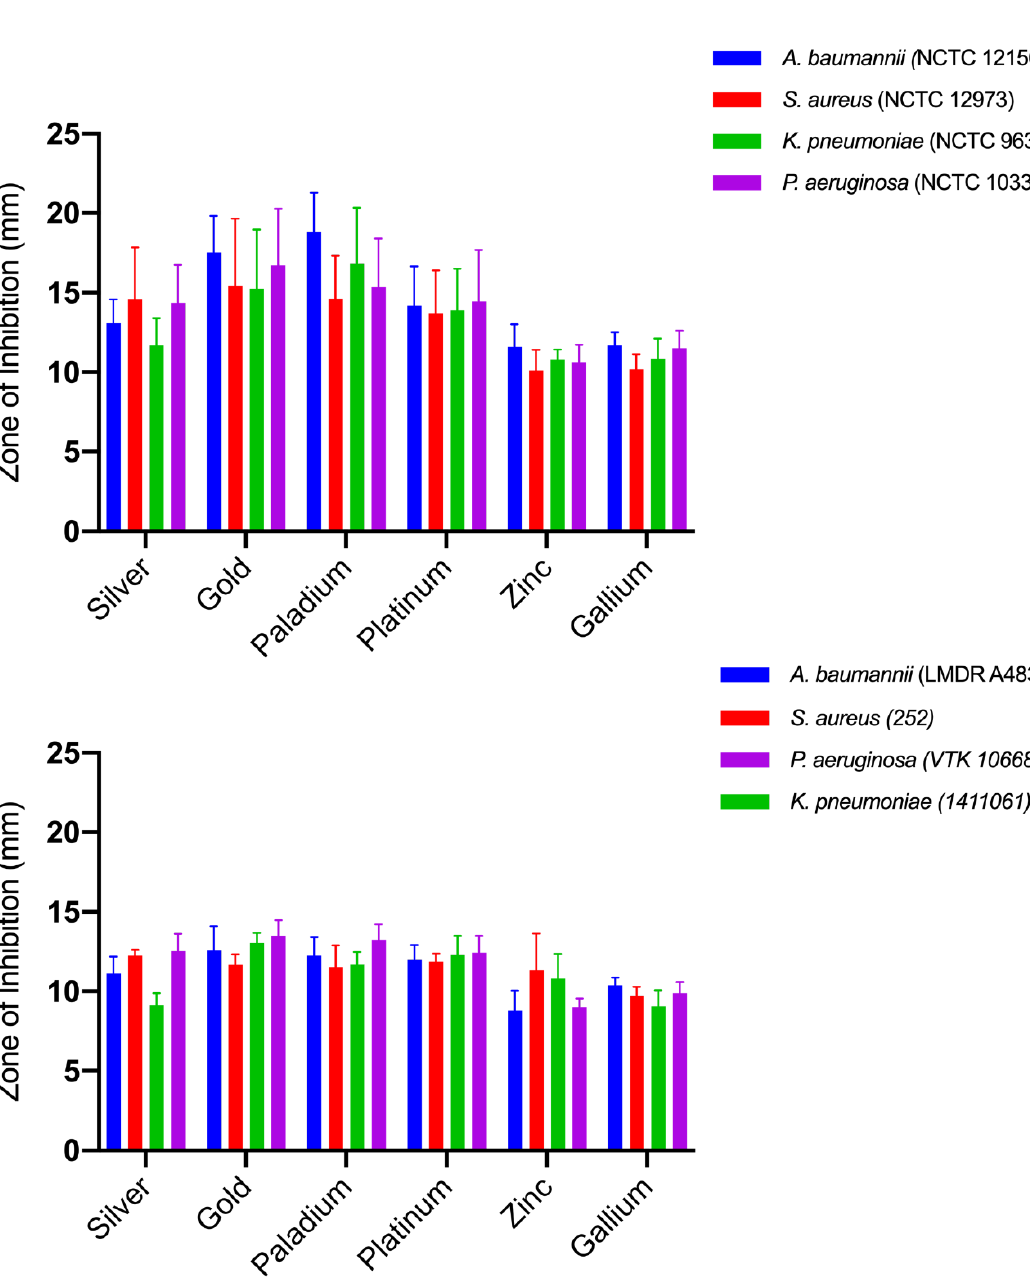
Figure 4. Zones of inhibition of graphene foams with metals on ( A ) antibiotic susceptible and ( B ) resistant bacteria ( n = 3).